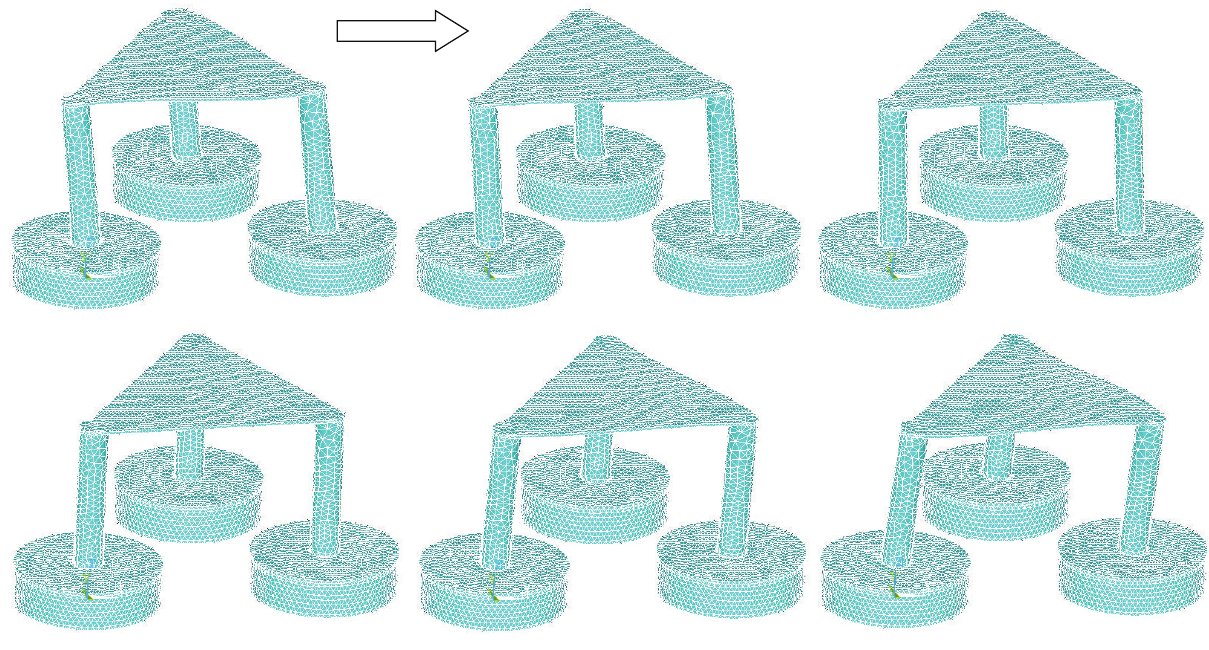
Figure 14: Second modal shape.